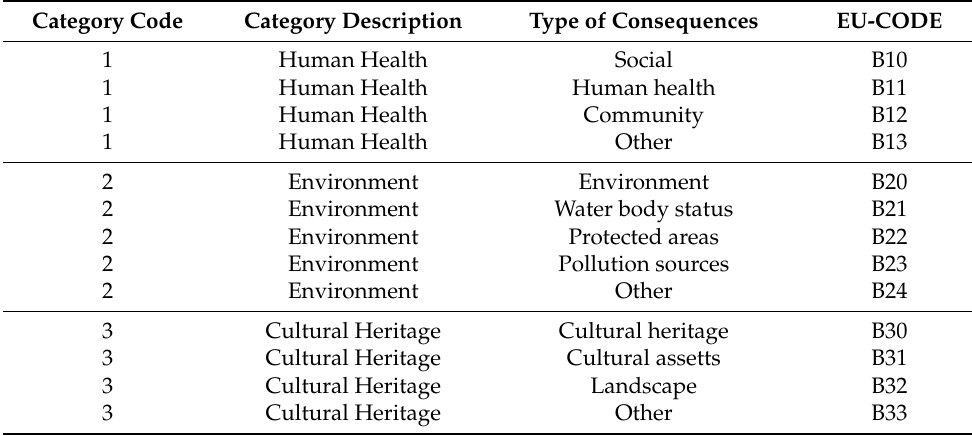
Table 3. Damage classification (from Flood Directive